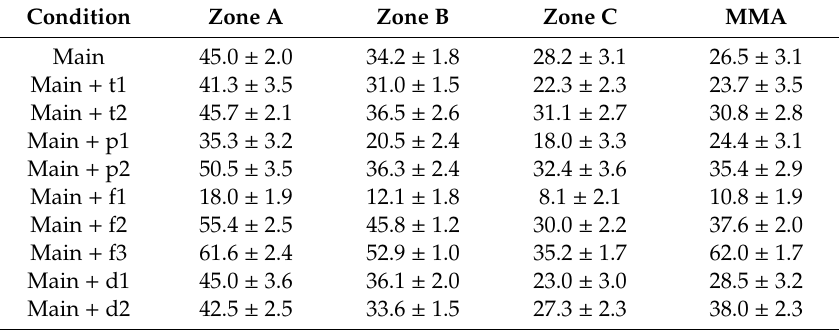
Table 5. Water contact angle (WCA) angle values for styrene and MMA coatings prepared under di ff erent experimental